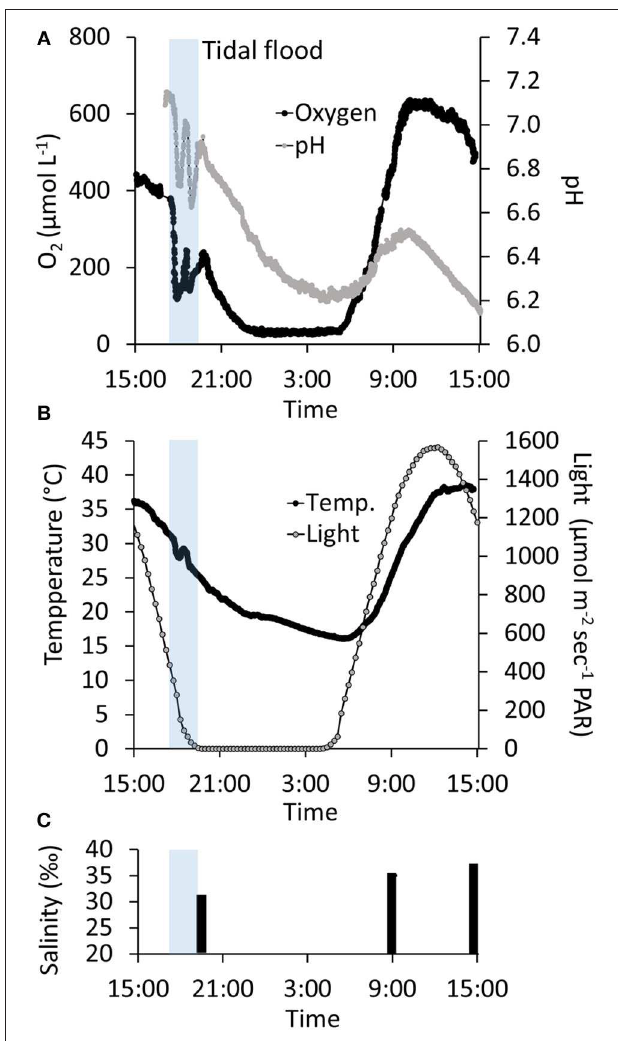
FIGURE 6 | Twenty-four hour time-series of the temporal variation in water column oxygen, pH, temperature, light exposure, and salinity in a salt marsh tidal pond. Transparent blue bar indicates the time-frame where the marsh was flooded at high tide (A) Twenty-fourh monitoring of oxygen and pH in the water column 2cm above the sediment surface. (B) Twenty-four hour monitoring of temperature and light. (C) Water column